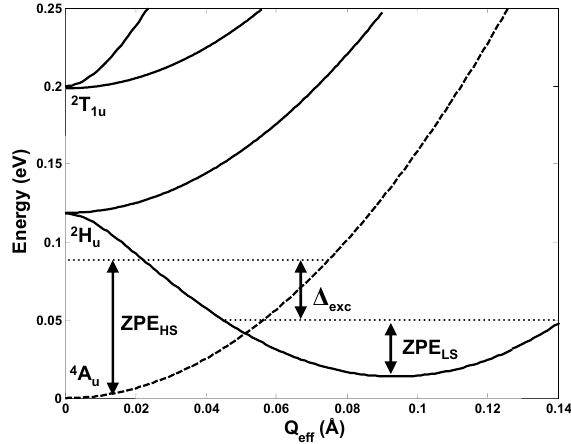
Figure 8. Cross-section of the APES of C 603 − along the effective mode that takes the system from the undistorted high-spin minimum to the distorted low-spin minimum due to the multimode ( H u + T 1u ) ⊗ h g PJT coupling [15]. The zero-point energies (ZPE) along this mode (which are different from the global ZPE) show that the lowest vibronic state associated with the electronic spin-doublet state is lower than that for the spin-quadruplet.